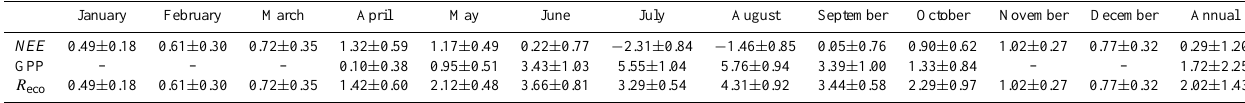
Table 3. The monthly and annual average values ( ± SD) of NEE, GPP, and R eco (gCm − 2 d − 1 ) . Data are from January 2004 to December 2006, and the symbol ( − ) indicate the value of GPP was zero during the no growing season.